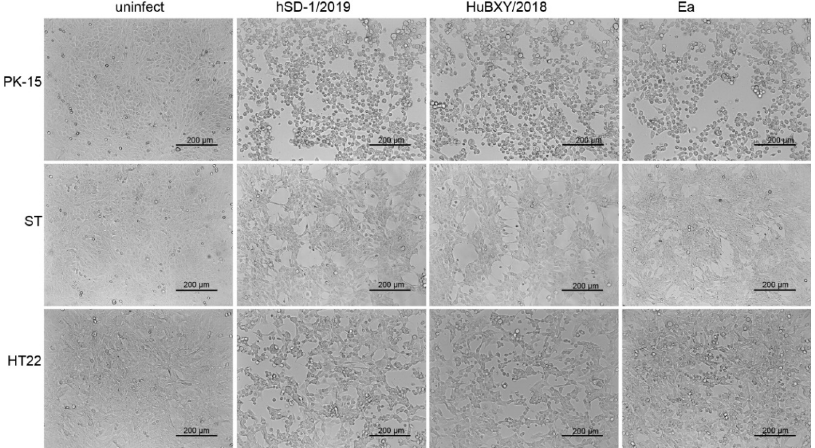
Figure 7. The cytopathic effects of PRV strain in swine and mouse cells. PRV strain hSD-1/2019, HuBXY/2018, and Ea induced similar cytopathic effects in PK-15, ST, and HT22 cells, respectively, which were characterized by single, rounded, and swollen cells.